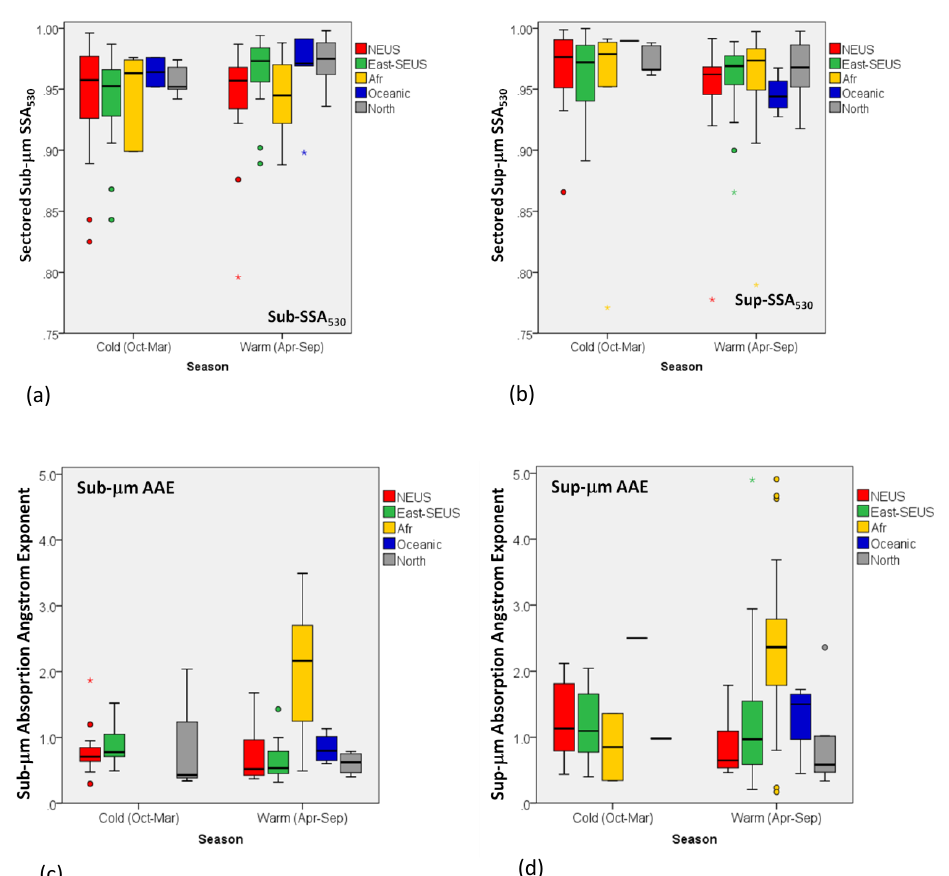
Fig. 5. Box and whisker plots (as described in Fig. 3) for (a) sub-µm SSA 530 , (b) super-µm SSA 530 , (c) sub-µm AAE, and (d) super-µm AAE associated with each of the source region flow patterns by